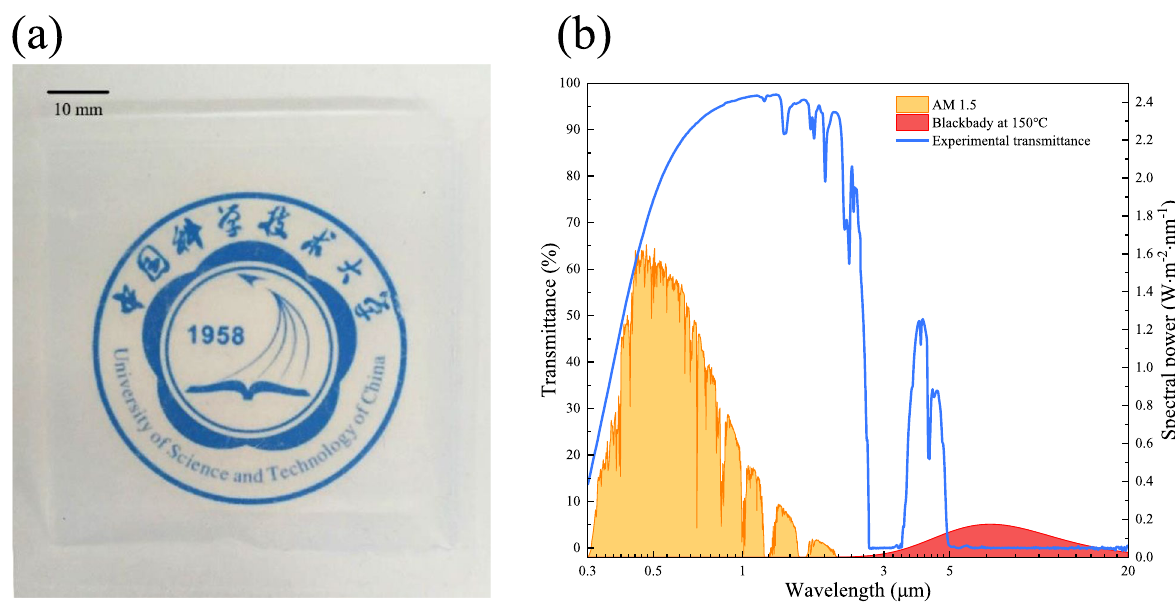
Fig. 1 a The image of 12.5-mm-thick transparent silica aerogel. b Measured transmittance curve of the aerogel ranges within 0.3 ~ 20